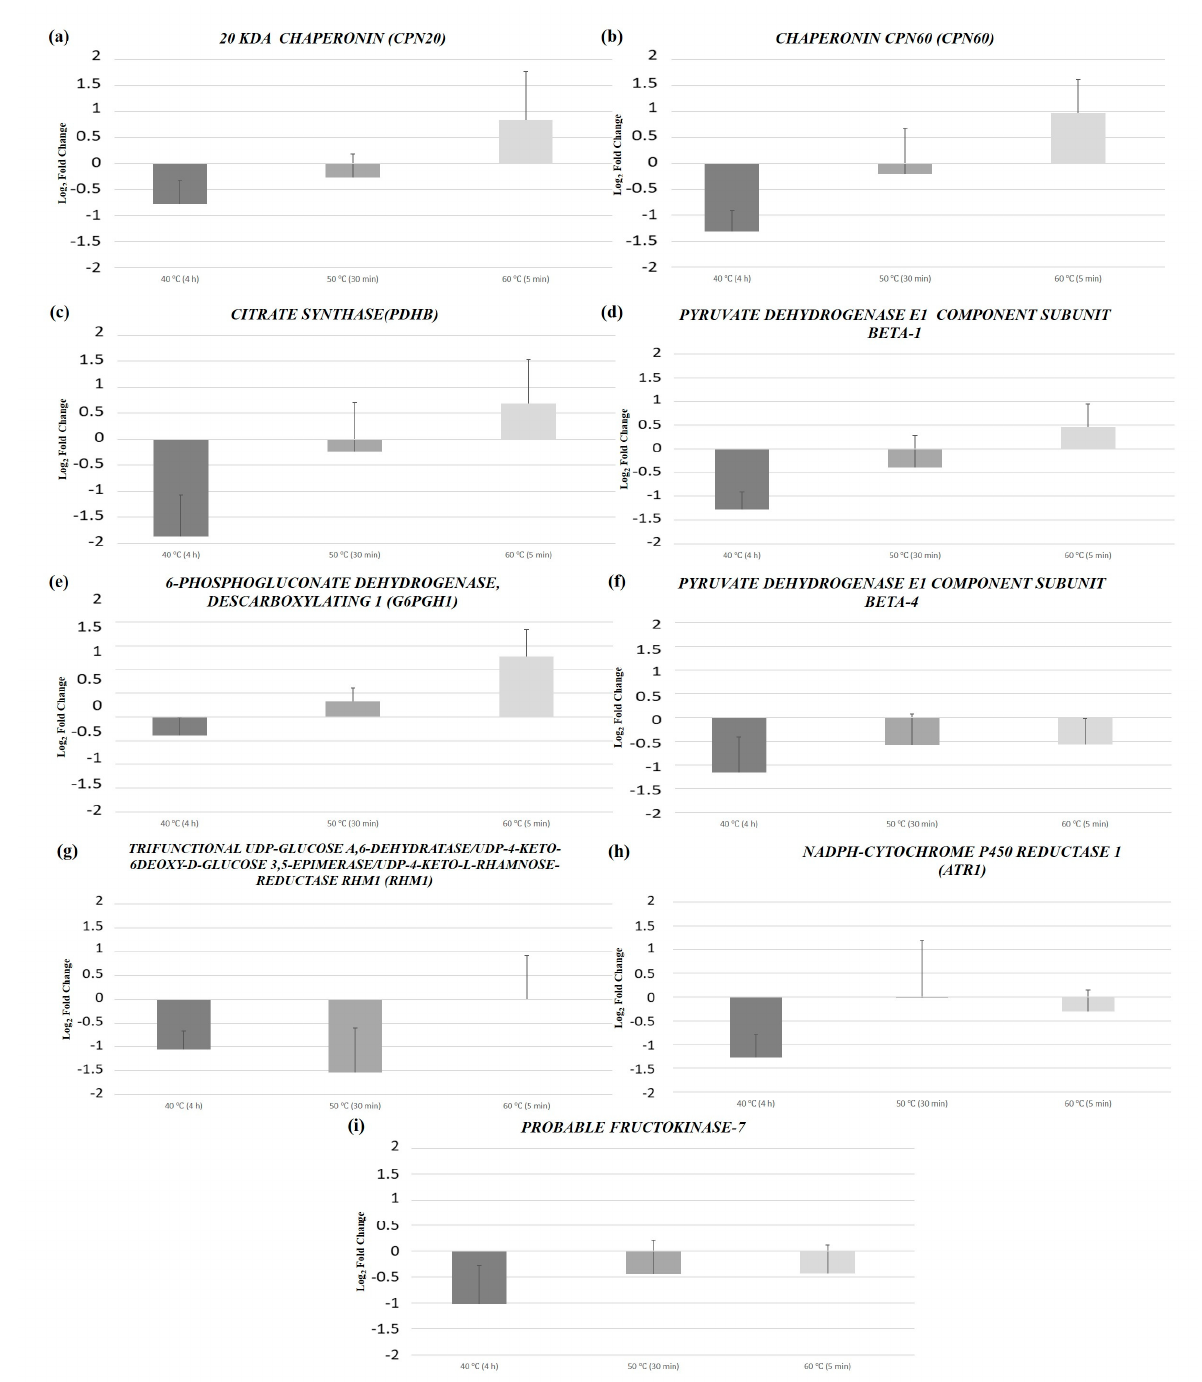
Figure 5. Relative expression fold change, with respect to the control (23 °C), of the nine transcripts from P. halepensis EMs induced under di ff erent temperature treatments [40 °C (4 h), 50 °C (30 min) and 60 °C (5 min)]: ( a ) 20 kDa CHAPERONIN (CPN20) ; ( b ) CHAPERONIN CPN60 ( CPN60) ; ( c ) CIT- RATE SYNTHASE (PDHB) ; ( d ) PYRUVATE DEHYDROGENASE E1 COMPONENT SUBUNIT BETA- 1 ; ( e ) 6-PHOSPHOGLUCONATE DEHYDROGENASE , DECARBOXYLATING 1 (G6PGH1) ; ( f ) PY- RUVATE DEHYDROGENASE E1 COMPONENT SUBUNIT BETA-4 ; ( g ) TRIFUNCTIONAL UDP- GLUCOSE A , 6-DEHYDRATASE/UDP-4-KETO-6DEOXY-D-GLUCOSE 3 , 5-EPIMERASE/UDP-4- KETO-L- RHAMNOSE-REDUCTASE RHM1 (RHM1) ; ( h ) NADPH-CYTOCHROME P450 REDUC- TASE 1 (ATR1) ; ( i ) PROBABLE FRUCTOKINASE-7 . Data are presented as mean values + SE.